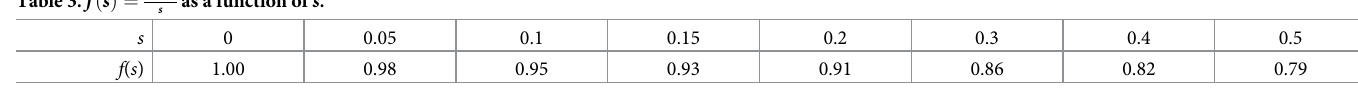
Table 3. f ð s Þ ¼ 1 (cid:0) e (cid:0) s